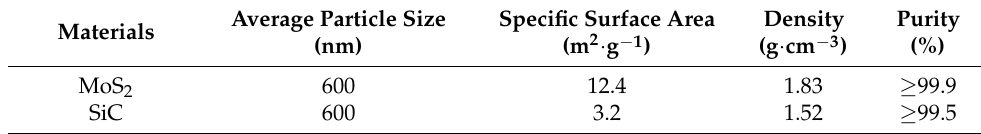
Table 1. The coating materials and properties.